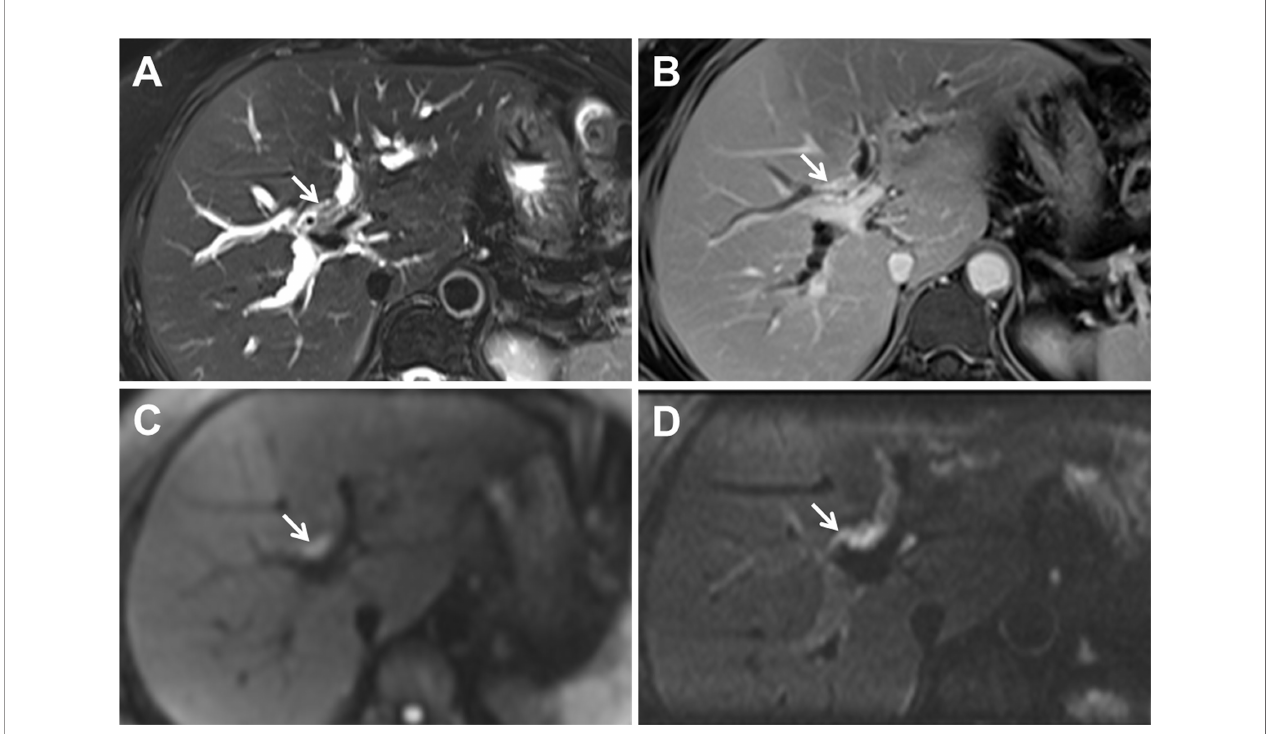
FIGURE 2 | A 54-year-old woman with Bismuth-Corlette type IIIa hilar cholangiocarcinoma. Axial (A) T2-weighted magnetic resonance imaging images indicating the hepatic duct with wall thickening and mild hyperintensities (arrow). (B) Gadoxetic acid-enhanced delay phase image shows thickening of the bile duct at the hepatichilum and the right hepatic ducts (arrow). Conventional echo-planar (c-EPI) diffusion-weighted imaging (DWI) (C) and zoomed echo-planar imaging (z-EPI) DWI (D) were obtained at b=800 s/mm 2 . The lesion bile duct at the hepatic hilum indicated hyperintensities. Both readers interpreted this tumor as type II on the basis of c-EPI DWI (C) . However, based on z-EPI DWI, the tumor was clearly observed at the hepatic hilum and the right hepatic ducts were noted as areas of hyperintensity. Both readers interpreted this tumor as type IIIa on z-EPI